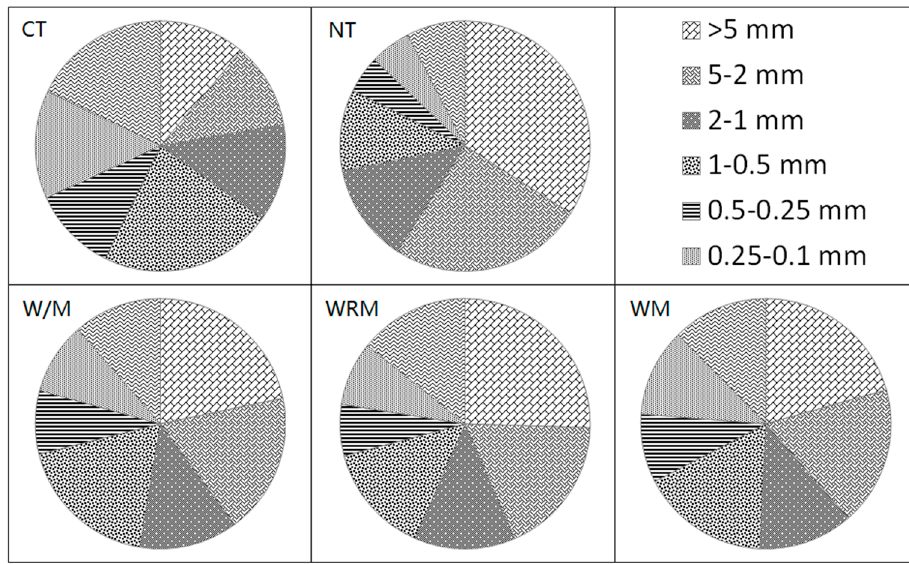
Figure 1. Percentage of soil aggregates under in different diameter classes within the 0–5 cm soil layer, as affected by cropping system and tillage method during two years.